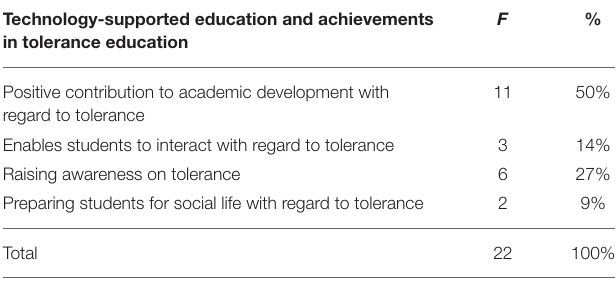
TABLE 3 | Students’ views on technology-supported teaching and achievements in tolerance